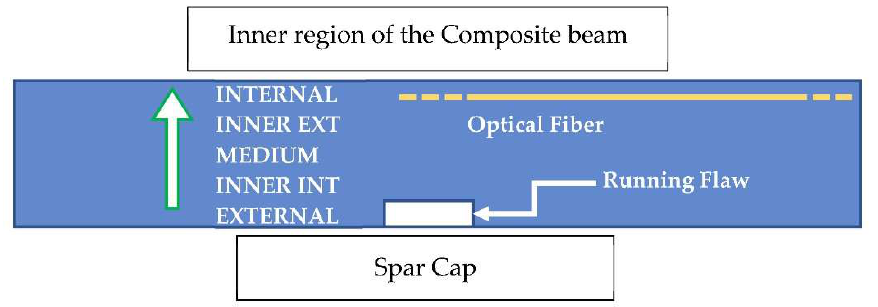
Figure 25. Strain difference function (με) between left and right bottom caps, retrieved within the bonding line. Red circles indicate approximate positions of the applied debonding at the top cap.